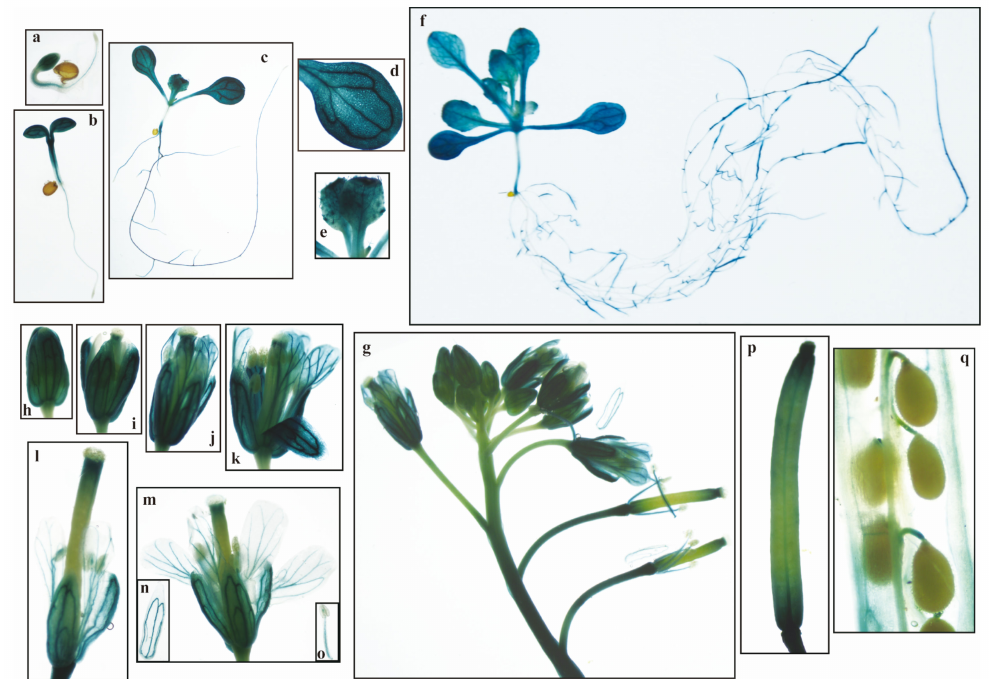
Figure 10. GUS activity of the PeuGASA15 promoter. ( a ) 3-day-old plant; ( b ) 4-day-old plant; ( c ) 7-day-old plant; ( d , e ) Cotyledons and young leaves of 7-day-old plant; ( f ) 14d-day-old plant; ( g ) inflorescence; ( h – k ) Expanding flow- ers; ( l ) Fading flowers; ( m ) Expanded flower; ( n ) Petal; ( o ) Stamen; ( p , q ) Silique.